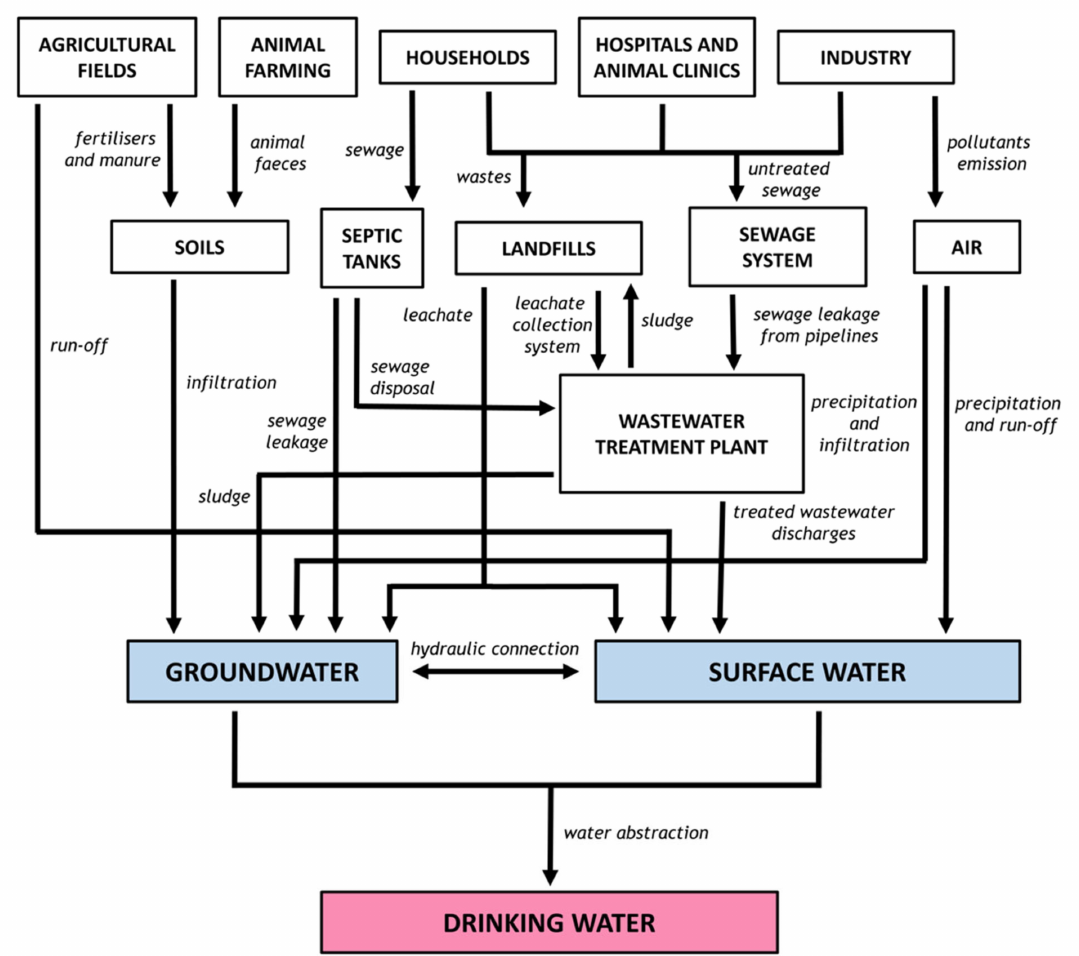
Figure 1. Possible sources and pathways of PPCPs in the natural environment. Municipal and hospital sewage may carry a significant load of pharmaceuticals and their metabolites from urine, faeces and expired drugs, disposed via sinks and toilets, which then find their way into wastewater and WWTPs [47,48]. Some residues from expired compounds are rinsed from waste by rainwater, passing to leachates, and then, through infiltration or run-off, to groundwater or surface water. Apart from municipal landfills,